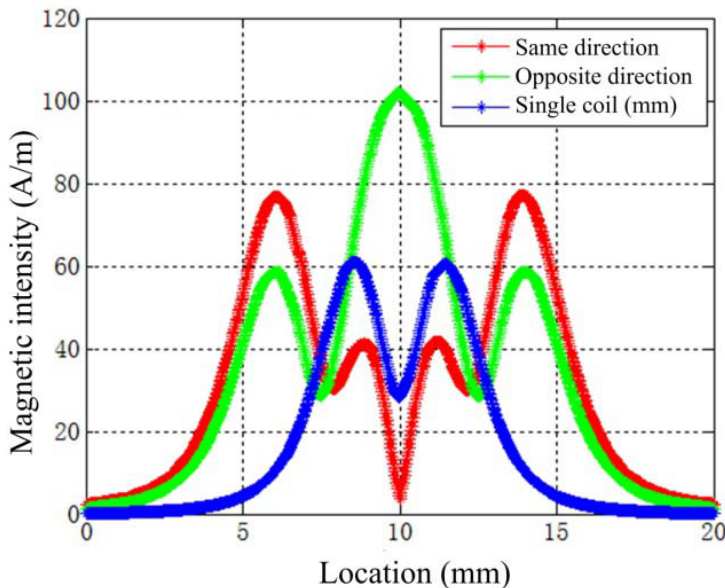
Figure 11. The magnetic intensity distributions along the center line on the surface of the measuring